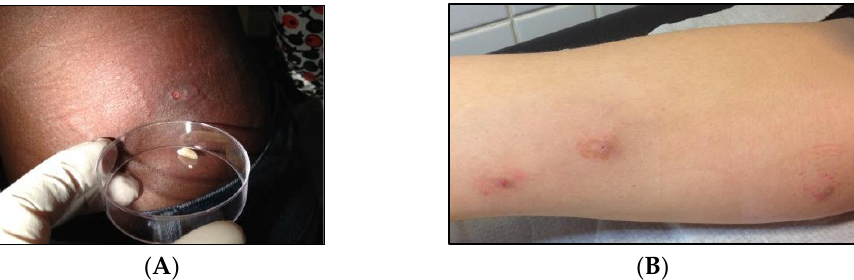
Figure 1. Cutaneous myiasis caused by Dermatobia hominis ( A ) and Cochliomyia hominivorax ( B ) larvae.